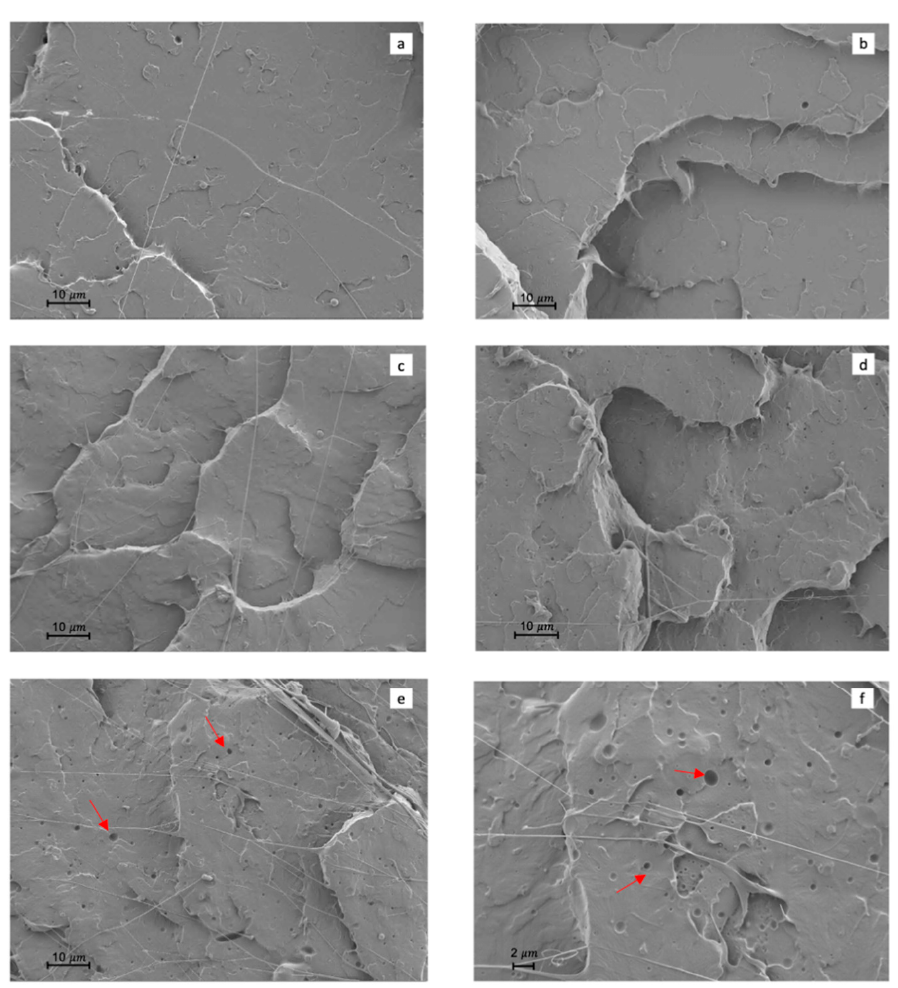
Figure 5. Fracture surface morphology of Charpy test at 1000 × by field emission scanning electron microscopy (FESEM): ( a ) neat PLA; ( b ) PLA_2.5%ECO; ( c ) PLA_5%ECO; ( d ) PLA_7.5%ECO; ( e ) PLA_10%ECO; and ( f ) PLA_10%ECO at 2500 ×.